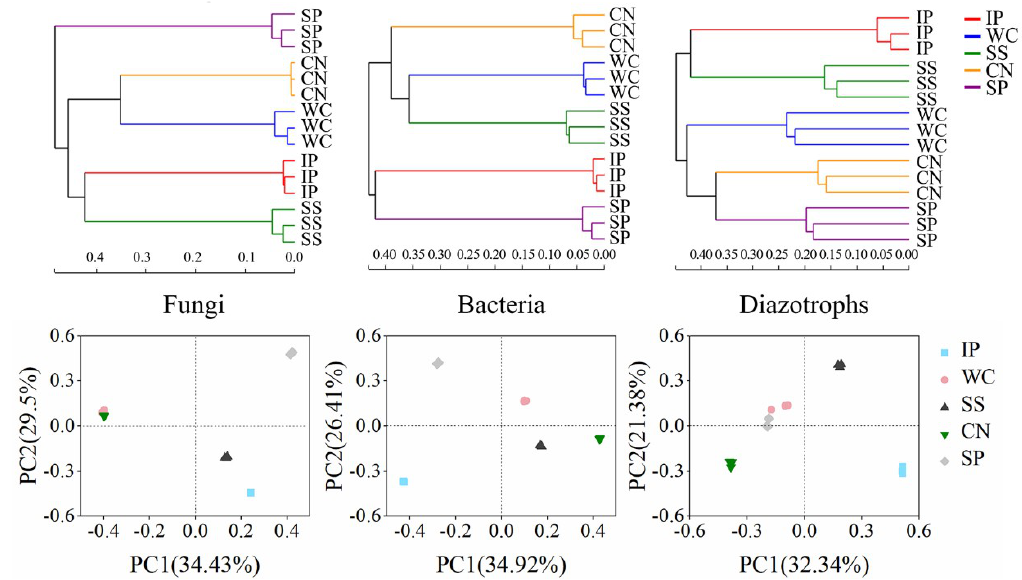
Figure 2. Hierarchical cluster analysis and principal coordinates analysis (PCoA) of fungi, bacteria and nitrogen-fixing bacteria community composition in sampled phyllosphere. IP indicates Ipomoea pes-caprae , WC indicates Wedelia chinensis , SS indicates Scaevola sericea, CN indicates Cocos nucifera, SP indicates Sesuvium portulacastrum .